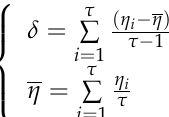
i f predicting label = actual label 0 i f predicting label (cid:54) = actual label